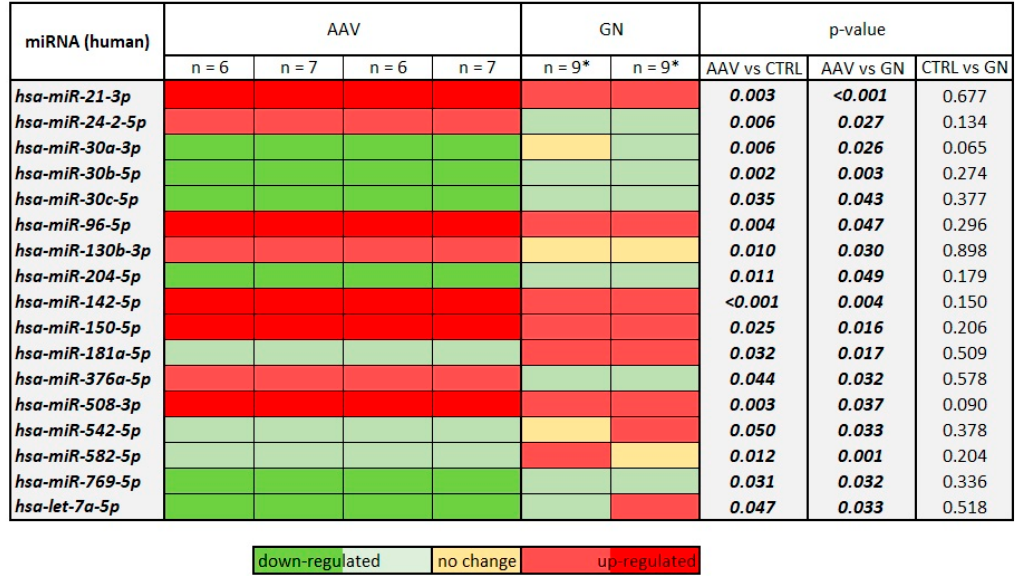
Figure 3. Expression heat map of 17 AAV-specific miRNAs in AAV and GN in comparison to controls without the clinical presentation of renal disease. Legend: AAV, ANCA-associated vasculitis; GN, patients with glomerulonephrites other than AAV; n, number of samples included in the pool; *, two samples were included in both pools of GN samples.